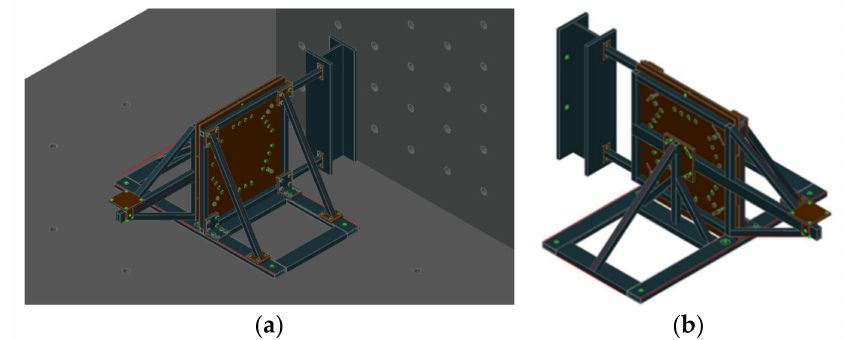
Figure 11. Computer-aided design (CAD) model of rotational shear fixture for the “SR3” pavers; ( a ) shown in the Engineering Materials and Structural Testing Laboratory (EMSTL); ( b ) the fixture